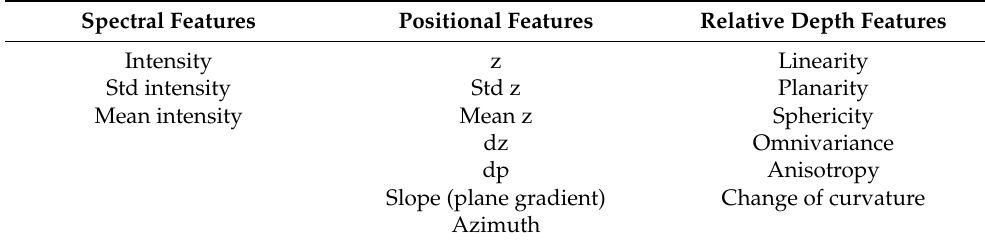
Table 1. Feature overview.